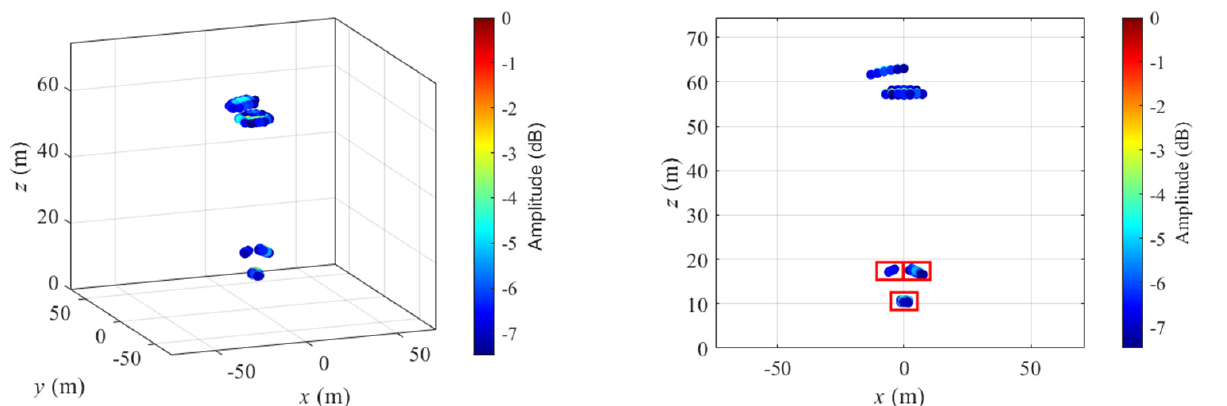
where It can be seen that the signal model (42) of the SDR-MIMO radar system is similar to that in (11). Thus, the conducted field experiment can be used to validate the proposed methods in this study. Via the back projection (BP) algorithm [35,36], the target image in the x-y-z domain obtained without the approximations in (40)–(42) is shown in Figure 29. It can be seen that the CR and the concrete walls can be well focused, as indicated by the red rectangles in the right sub-figure. Via the 3D IFFT, the target image in the α - β - χ domain obtained based on (42) and its corresponding image in the x-y-z domain are shown in Figure 30. The consistency between Figures 29 and 30 well validates the approximations in (40)–(42). It should be mentioned that, similar to the simulations, the imaging resolutions of the target parameters α , β , and γ obtained by the 3D IFFT are expressed as ∆ α = 1/ M , ∆ β = 1/ N , and ∆ γ = 1/ Q . Then, according to definitions of α p , β p , and χ p , the imaging resolutions of the target position x p , y p , and r p can be derived as ∆ x p = 2 r p ∆ α = 2 r p / M , ∆